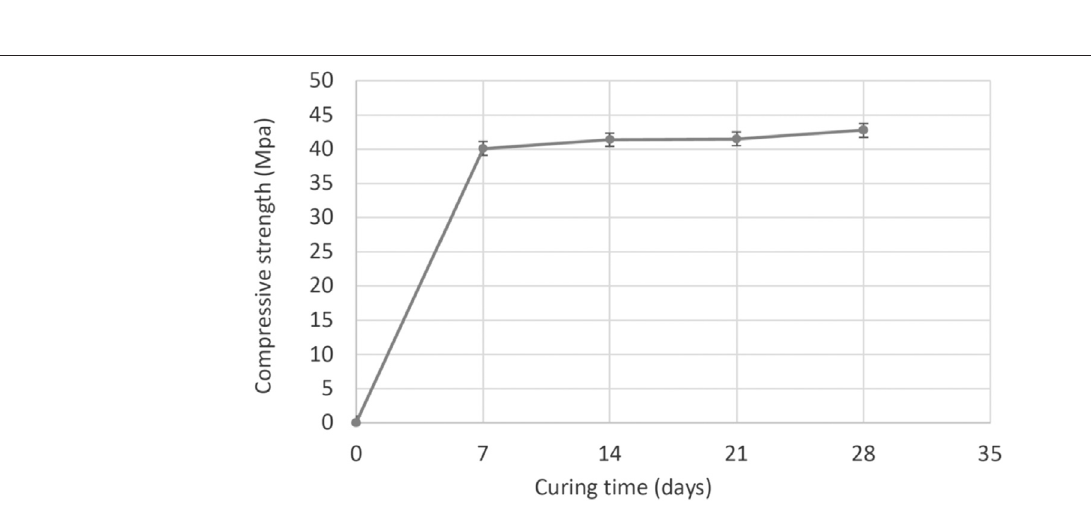
FIGURE 3 | Cement mortar compressive strength variation with